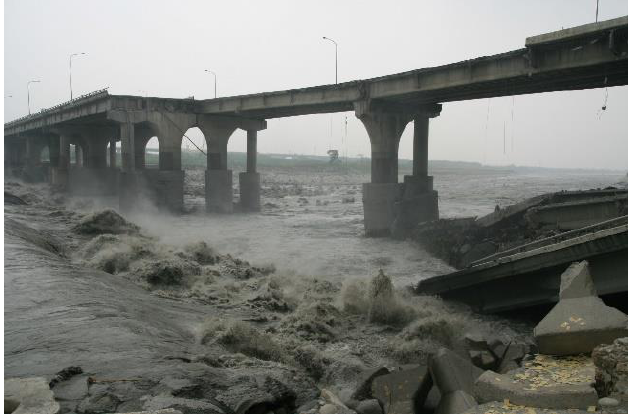
Figure 1. Failure of Houfeng Bridge in Dajia River, Taiwan due to pier-scour in September 2008 (courtesy of Yee-Meng Chiew).